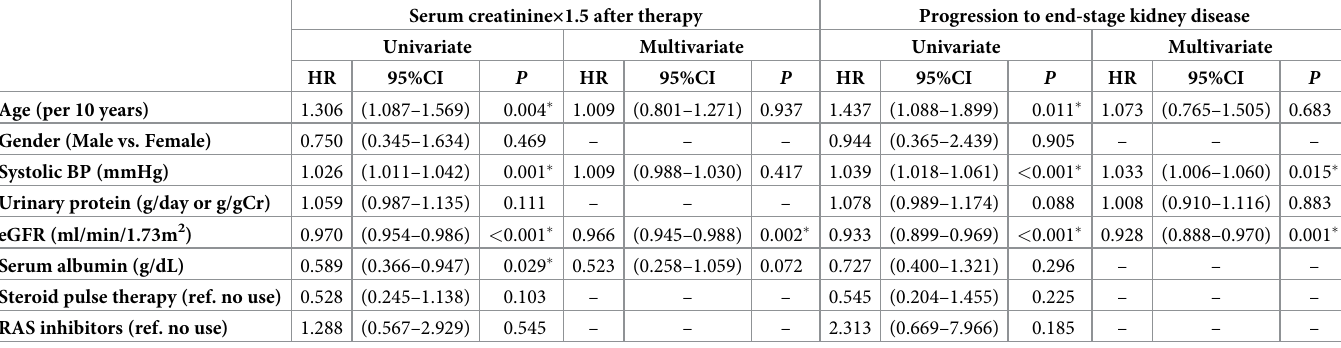
Table 5. Association of Serum creatinine × 1.5 and progression to end-stage kidney disease in patients with